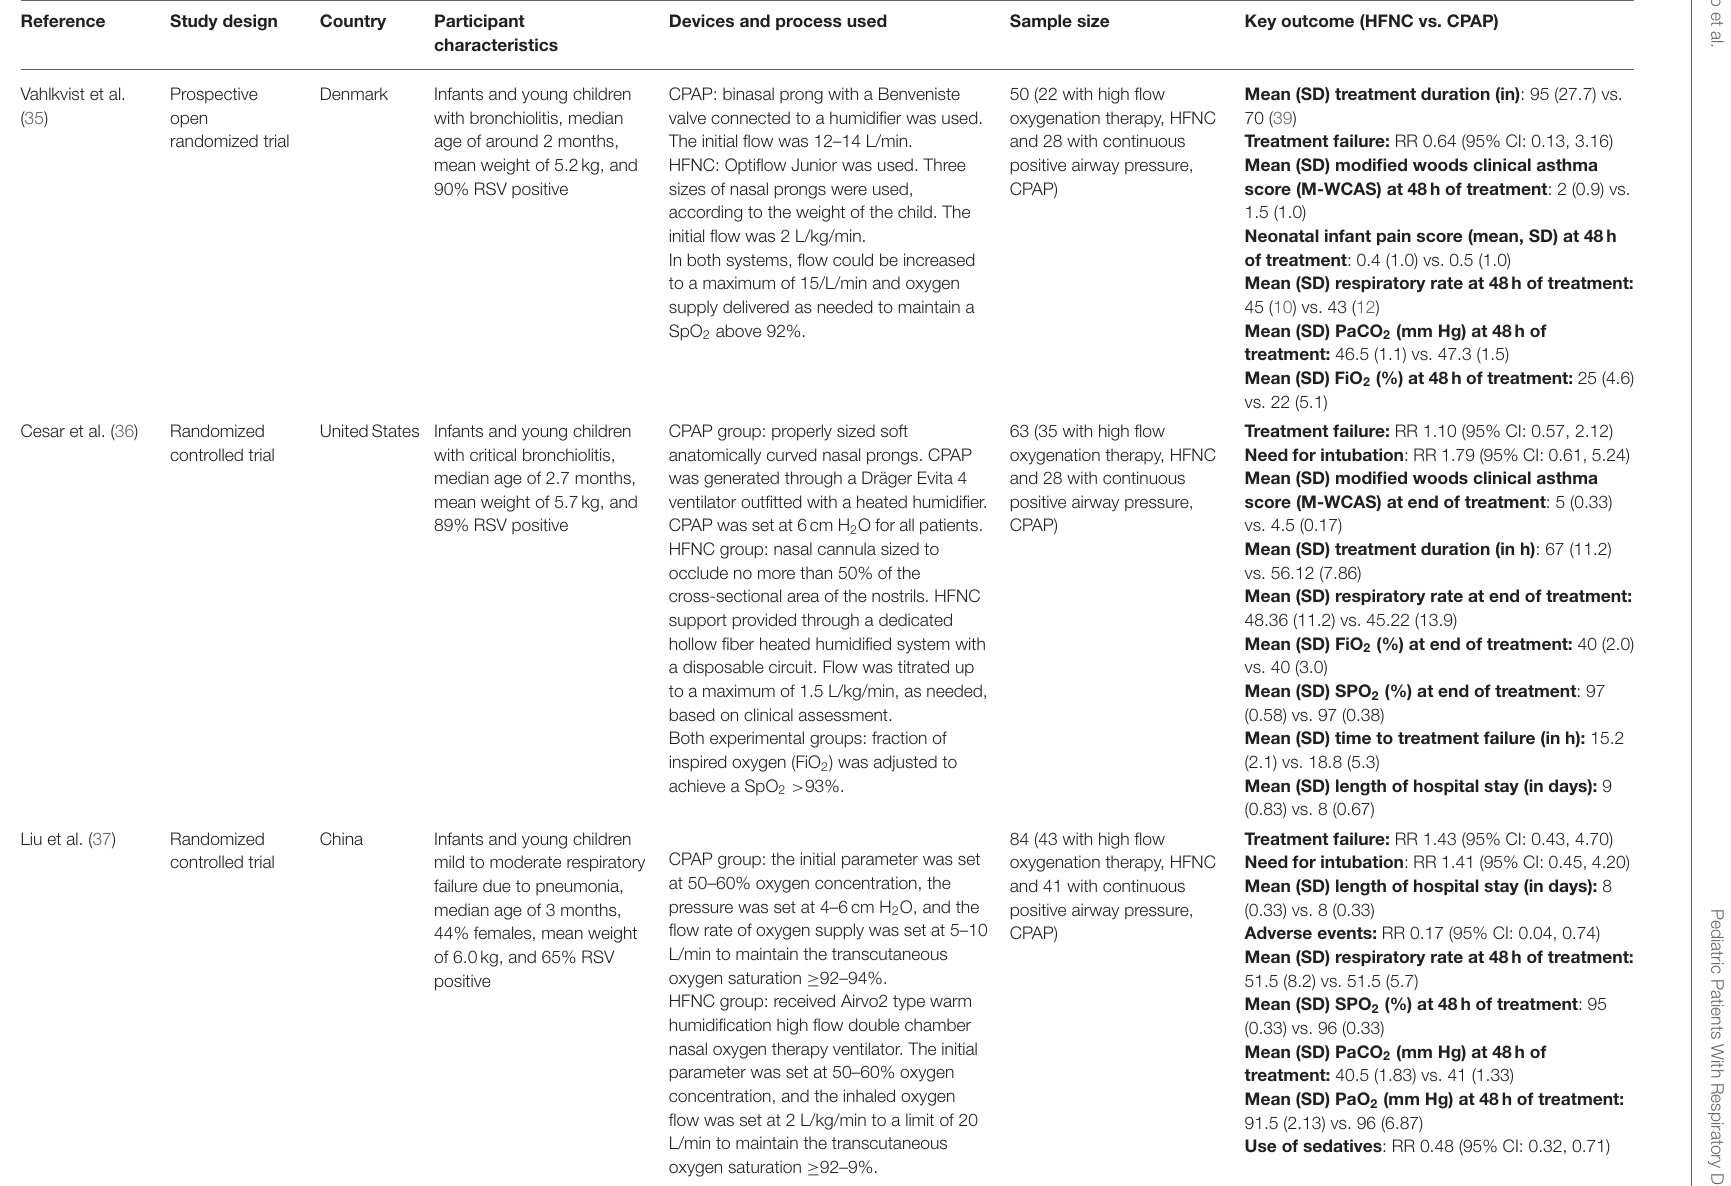
TABLE 1 | Characteristics of the studies included in the